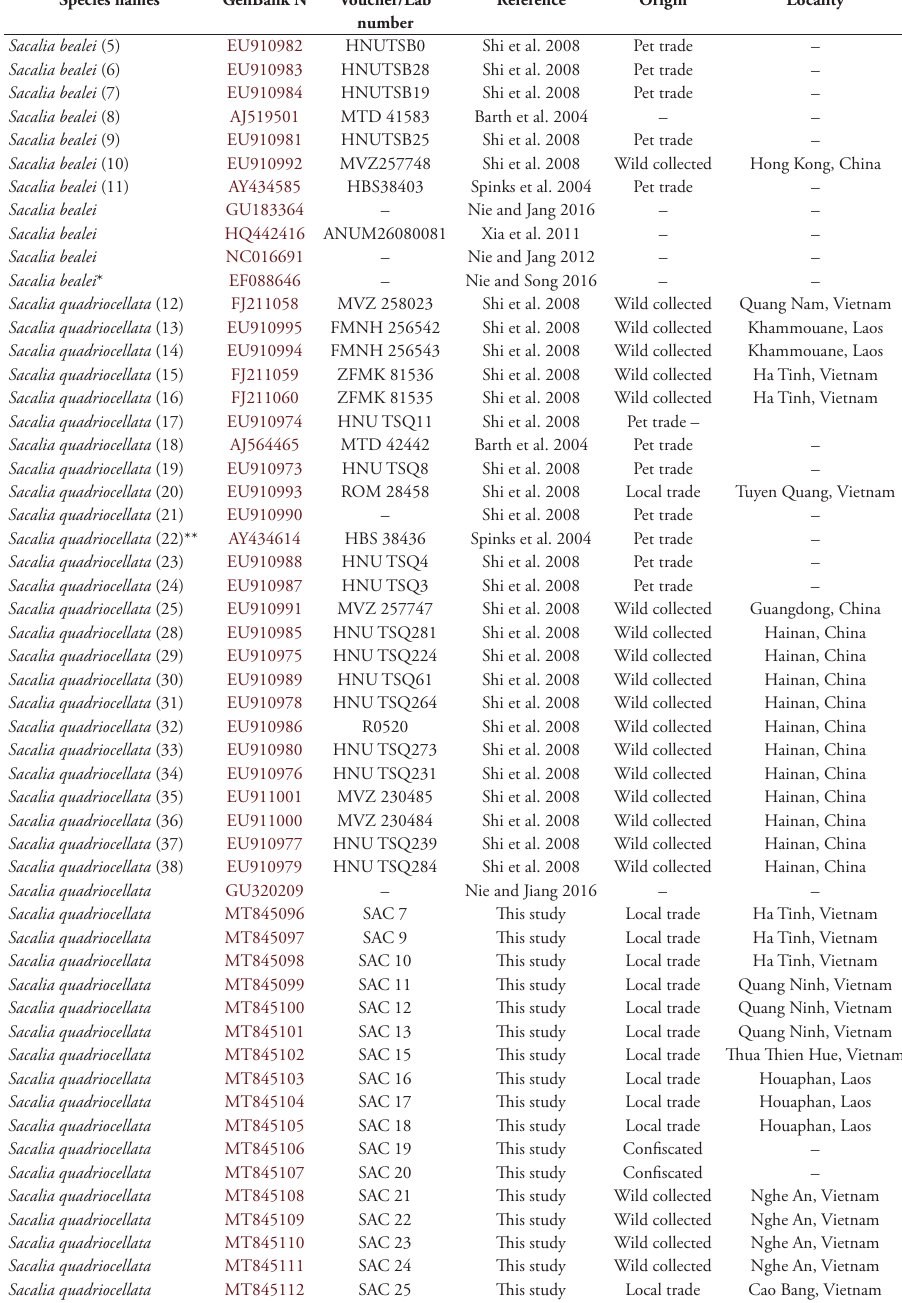
Table 1. GenBank accession numbers and associated voucher/laboratory numbers of ingroup taxa used in this